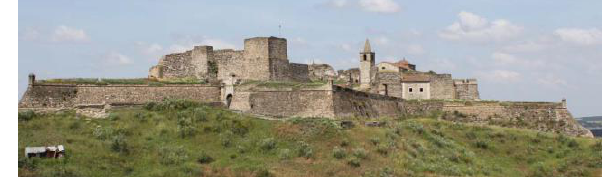
Figure 1. View of Juromenha Fortress site.